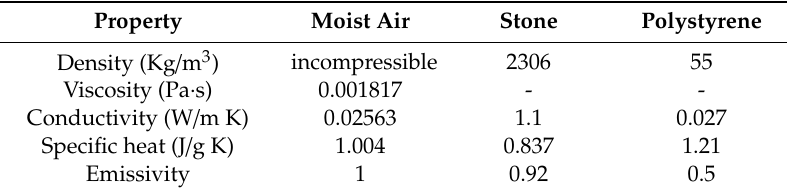
Table 2. Physical properties of the materials used.